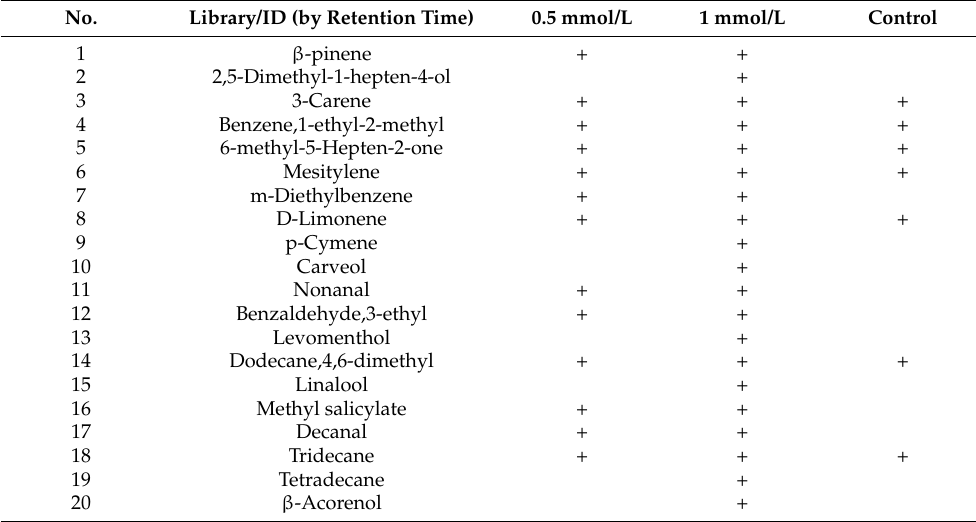
Table 1. Compounds identified from wheat plant volatile extracts via GC −